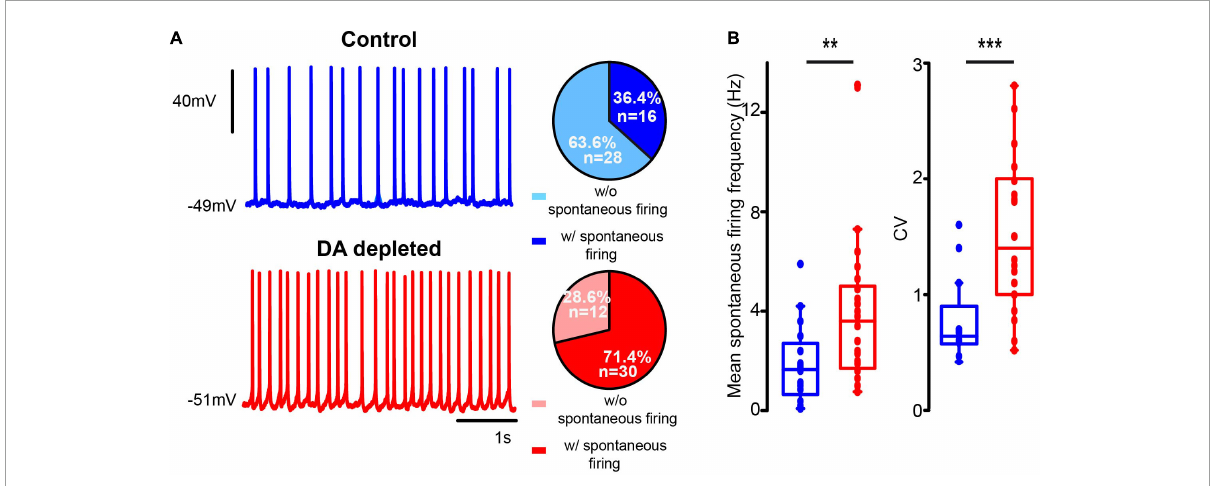
FIGURE4 DA-depleted cholinergic interneurons had increased spontaneous firing. (A) Top: a representative whole cell patch clamp electrophysiological recording of a CIN exhibiting spontaneous firing (zero current) in control conditions. Bottom: a CIN exhibiting spontaneous firing (zero current) from the DA-depleted sample. Pie plots on the right show percentages of neurons found with and without spontaneous firing at the time of recording (**** P < 0.0001; df = 1; χ 2 ). (B) Box-plots show samples of mean firing rate obtained from 1 s of spontaneous firing from electrophysiological recordings (** P = 0.0061; Mann–Whitney U) and coefficient of variation (*** P = 0.001; Mann–Whitney U) during spontaneous firing. Control n = 16 neurons from 7 different animals; DA-depleted n = 30 neurons from 14 different